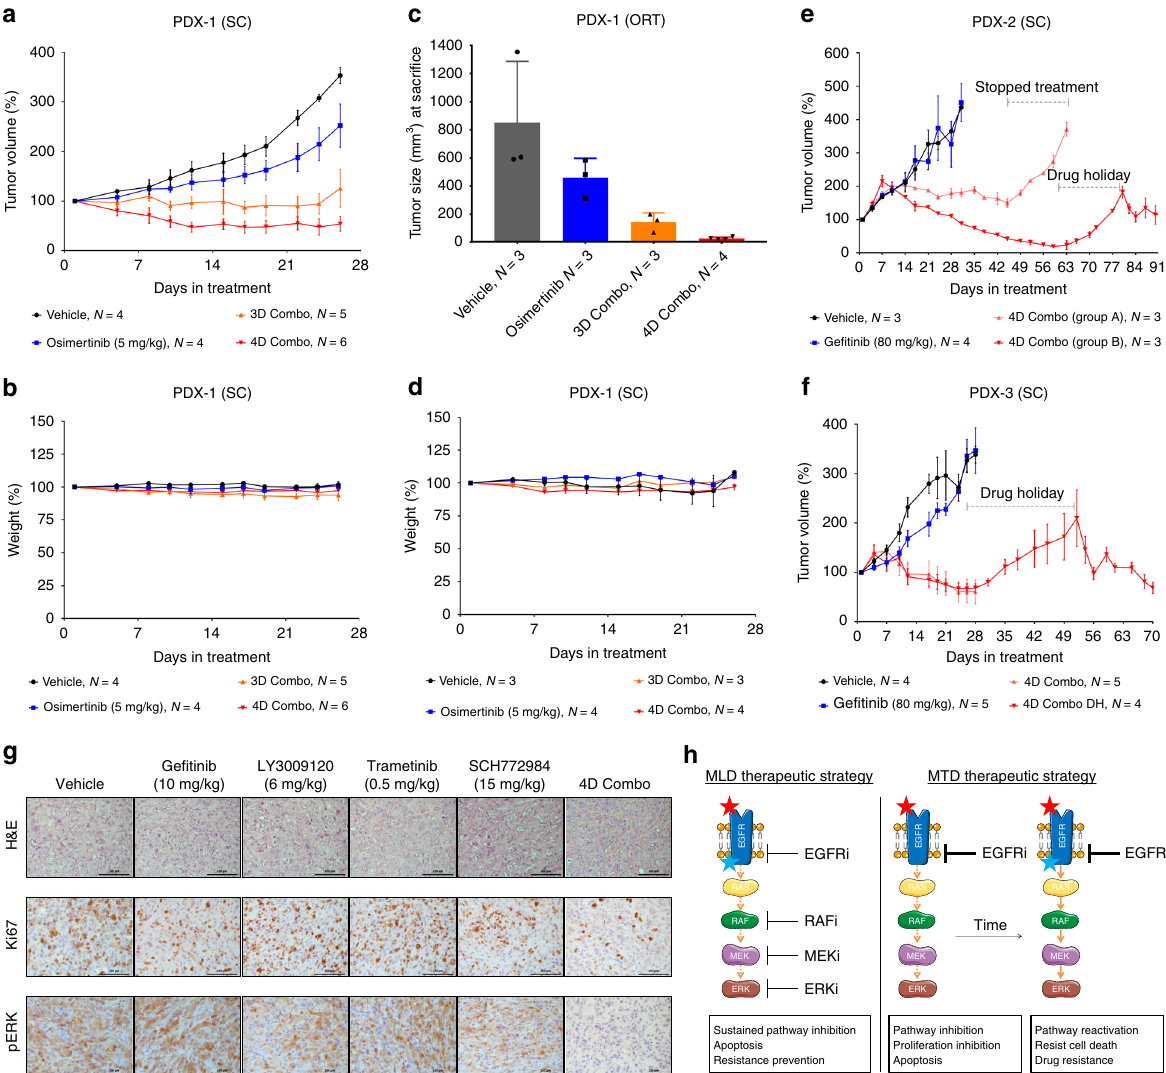
Fig. 4 MLD therapy induces tumour regression without toxicity in vivo. a – f Patient derived xenografts (PDX) are sensitive to MLD therapy. PDX tumours (see Supplementary Table 3) were implanted subcutaneously ( a , e , f ) or orthotopically in the lungs ( c ) of Crl:NU-Foxn1nu mice. PDX1 was implanted both subcutaneously ( a ) and orthotopically in the lungs ( c ). We de fi ned the in vivo LD as 20 – 30% of the MTD for each of the individual drugs – ge fi tinib (10 mg/kg), LY3009120 (6 mg/kg), trametinib (0.5 mg/kg) and SCH772984 (15 mg/kg). In a – d after tumour establishment, mice were treated 5 days/ week with vehicle, with osimertinib (5 mg/kg) and with 3D or with 4D Combos for 26 days, after which mice were sacri fi ced. In a tumour volume percentages ±SEM is shown, in c tumour size (mm 3 ) at sacri fi ce ±SEM is shown and in b and d the mice weight percentages ± SEM is shown. e After tumour establishment, mice were treated 5 days/week with Vehicle ( N = 3), with ge fi tinib (80 mg/kg) ( N = 4) or with 4D Combo for 6 weeks (group A, N = 3) or with 4D Combo for 8 weeks (group B, N = 3). Mice treated with vehicle and ge fi tinib were sacri fi ced when tumours reached ~2000mm 3 . After 6 weeks, Group A was taken off treatment and mice were sacri fi ced when tumours reached ~2000mm 3 . After 8 weeks Group B was taken off treatment and was given 3 weeks of drug holiday. Mice were then treated for another 2 weeks with 4D combo, after which they were sacri fi ced. Tumour volume percentages ±SEM is shown. f After tumour establishment, mice were treated 5 days/week with vehicle ( N = 4), with ge fi tinib (80 mg/kg) ( N = 5) or with 4D Combo ( N = 9) for 4 weeks, after which mice were sacri fi ced, except for 4 animals from the 4D Combo group. These 4 mice were spared and were given 3 weeks drug holiday (4D Combo DH group), followed by another 3 weeks of treatment, after which they were sacri fi ced. Tumour volume percentages ±SEM is shown. g H&E, Ki67 and pERK stainings from tumour sections of PC9 xenografts. A representative staining image from each cohort ( N ≥ 6) is displayed. Scale bars 100 µ m. h Schematic representation of the MLD therapy for the treatment of EGFR mutant